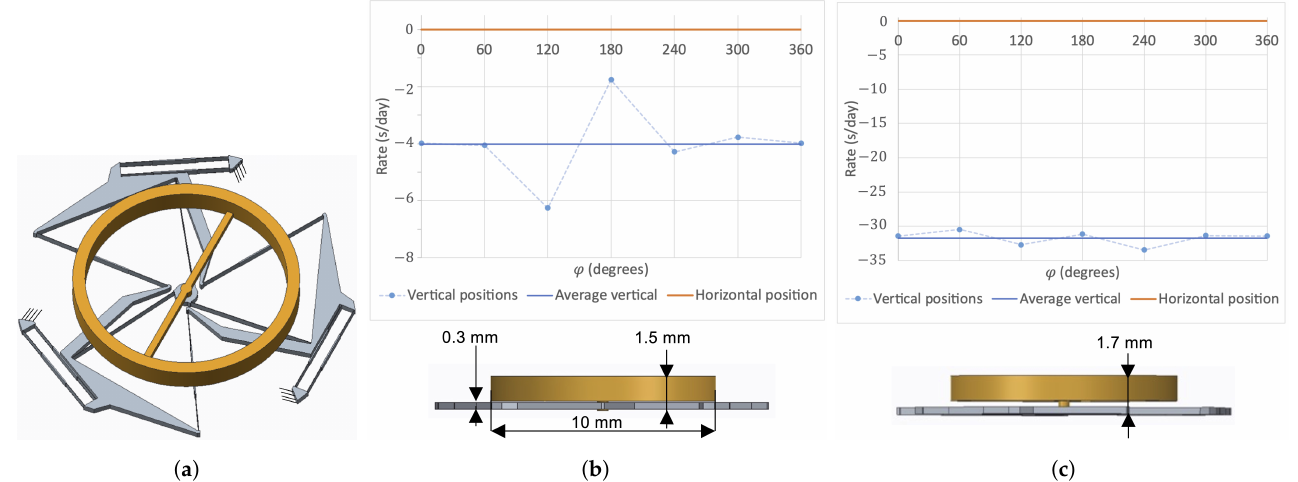
Figure 9. Watch-scale silicon TRIVOT oscillator ( a ) with COM offset from the flexure plane using a separate balance wheel and its daily rate for varying angle ϕ of the gravity load in the oscillation plane (vertical positions) and for gravity acting along the rotation axis (horizontal position) with nominal COM offset ( b ) and increased offset ( c ).